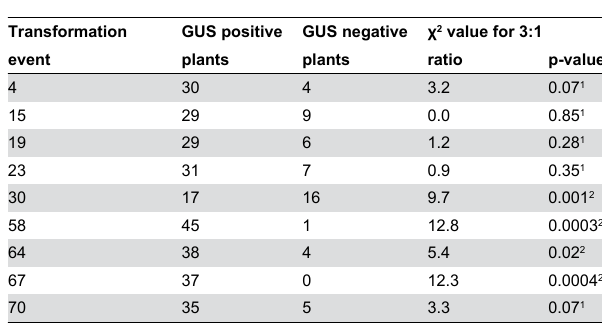
Table 4. Segregation of GUS expression in the T generation of PI269842